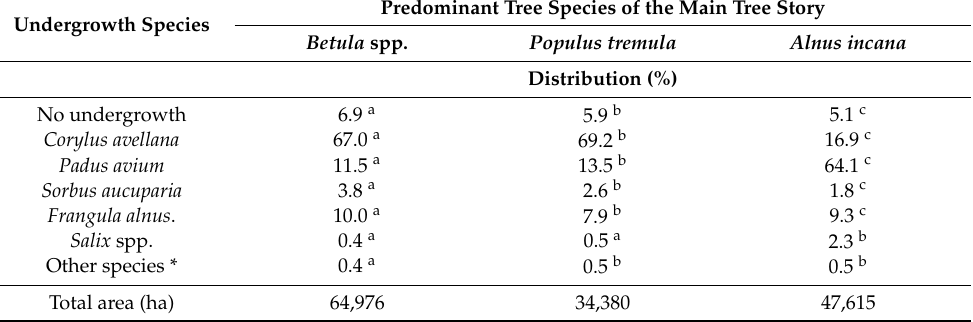
Table 2. Percentage distribution of the predominant undergrowth species area in the Betula spp., Populus tremula , and Alnus incana stands. The values followed by different letters a, b, and c indicate statistically significant differences between the stands at p < 0.05. Predominant Tree Species of the Main Tree Story Undergrowth Species Betula spp.